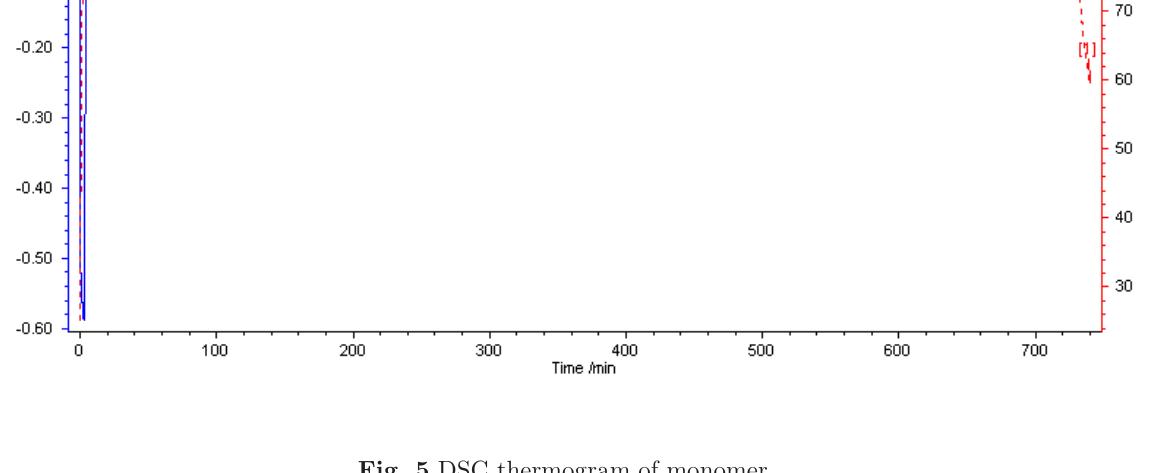
Fig. 5 DSC thermogram of monomer.